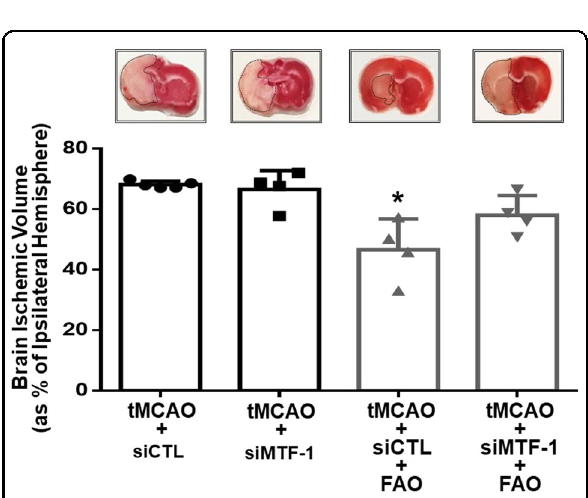
Fig. 6 Knocking down MTF-1 by siRNA strategy reverted RLIP- induced neuroprotection. Evaluation of the ischemic damage in rats exposed to: (i) tMCAO and icv-injected with a non targeting siRNA (tMCAO + siCTL) or a siRNA for MTF-1 (tMCAO + siMTF-1) and; (ii) to tMCAO + FAO and icv-injected with a non targeting siRNA (tMCAO + siCTL + FAO) or a siRNA for MTF-1 (tMCAO + siMTF-1 + FAO). * p < 0.05 vs. tMCAO + siCTL by one-way ANOVA followed by Bonferroni test. Each column represents the mean ± SEM ( n =